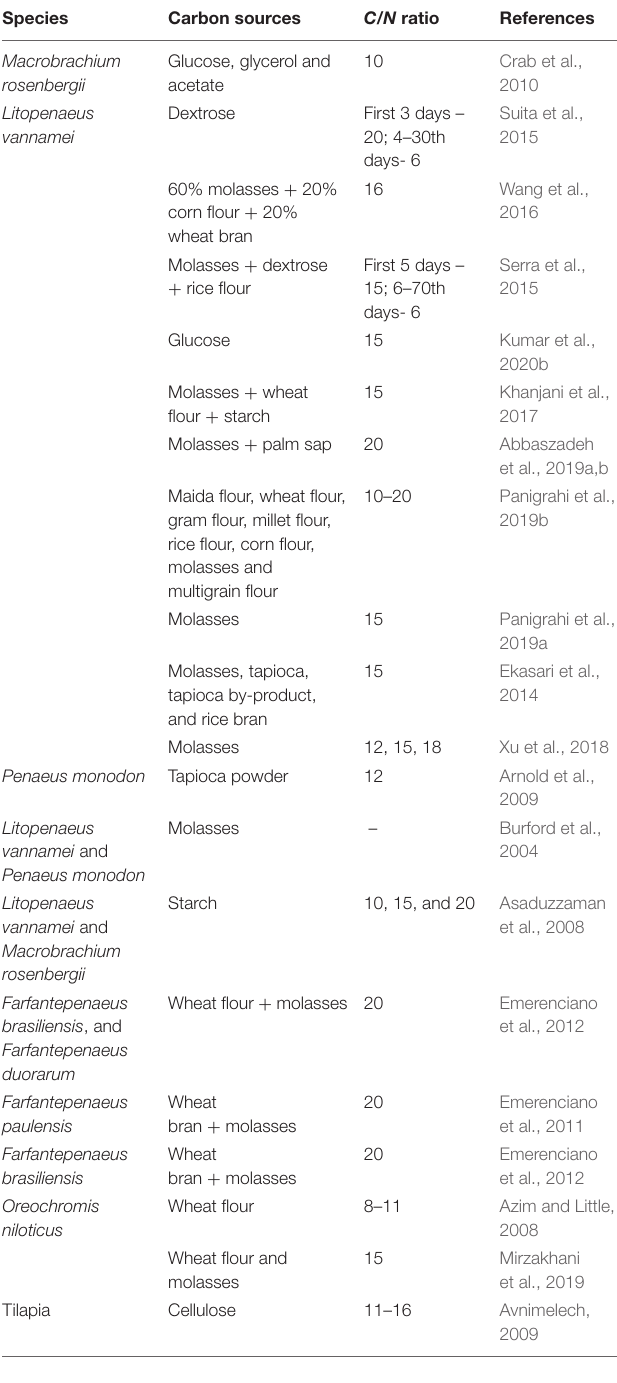
TABLE 1 | The use of different carbon sources and C / N ratio for development of stable biofloc culture system. Species Carbon sources C / N